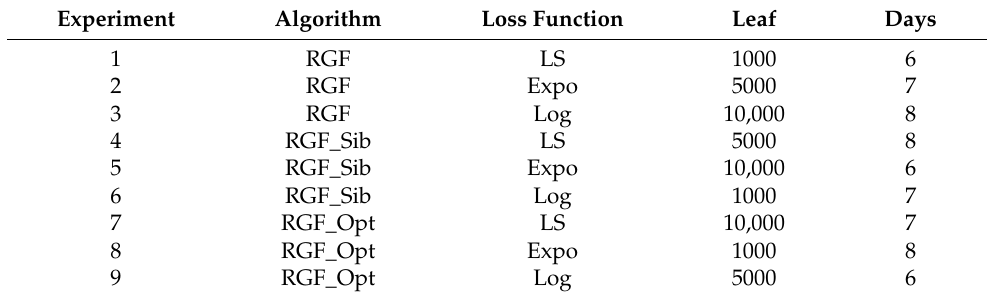
Table 3. The design of the